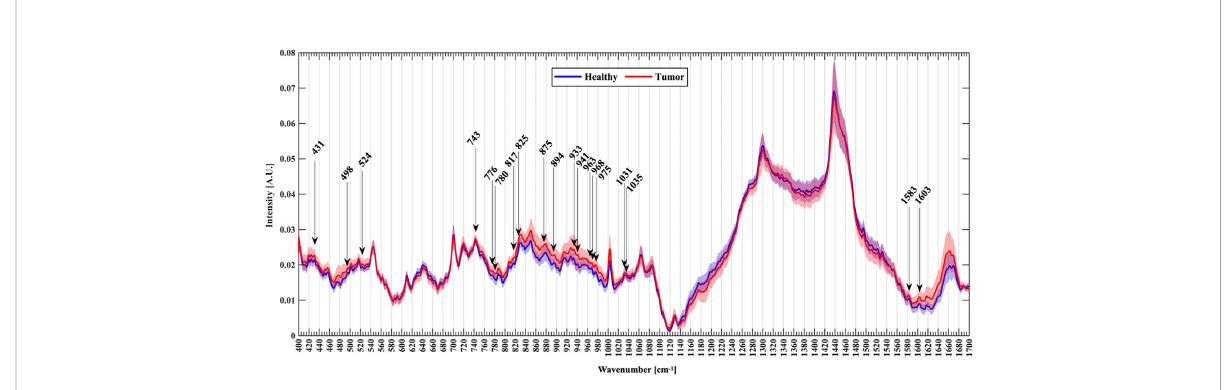
FIGURE 1 An example of Raman spectroscopy shows normalized mean spectra with standard deviation between healthy (blue) and tumor patients (red). Arrows mark the new Raman peaks about glioma identi fi ed by the researcher